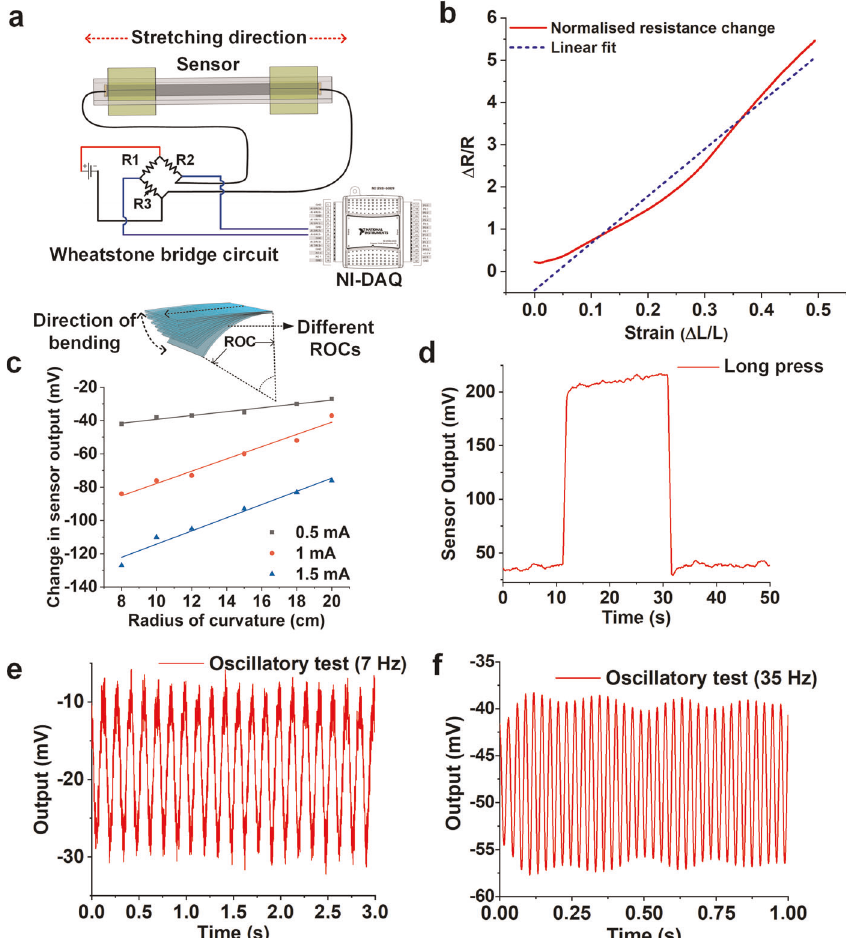
Fig. 7 Response plots of CNF bundle strain sensor. a Schematic representation of the experimental setup for the tensile strain sensing characterization. b Plot of averaged resistance change versus tensile strain in the CNF-PDMS strain sensor for tensile strains up to 50%. c Static